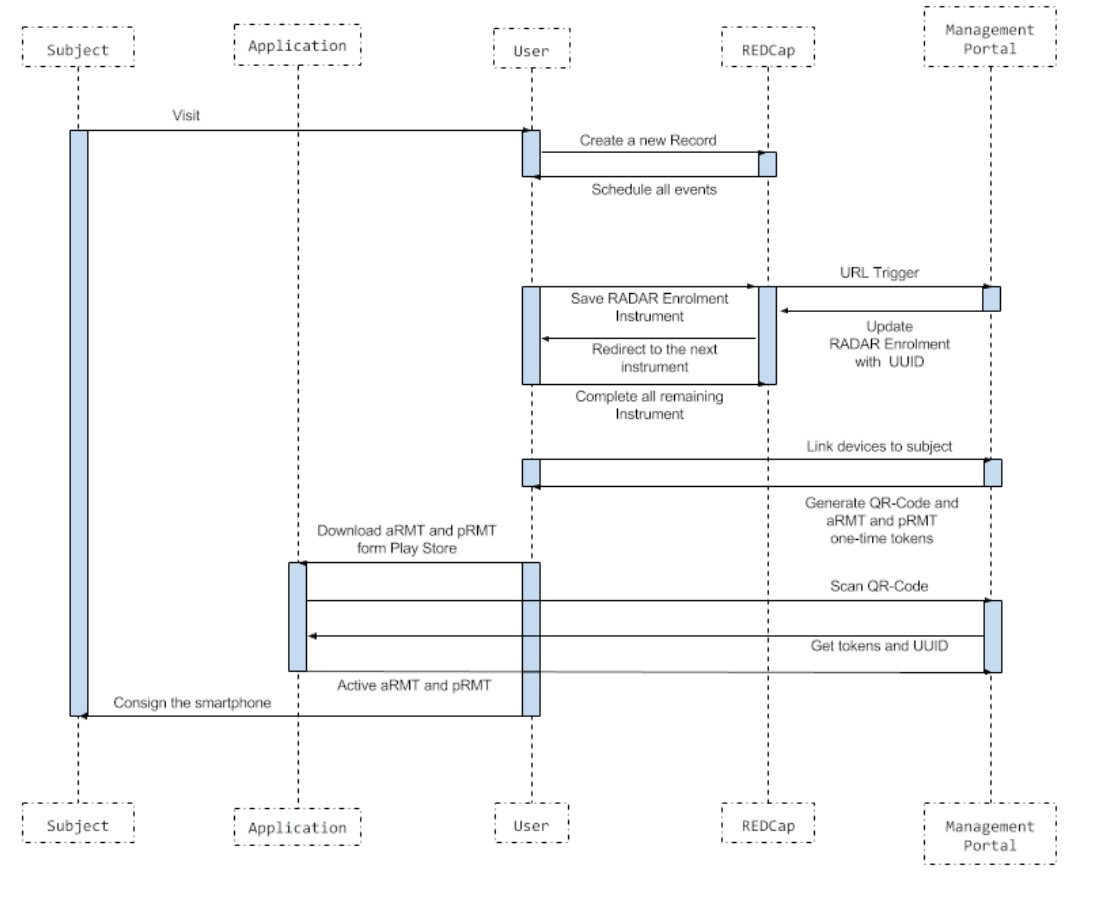
Figure 9. User registration